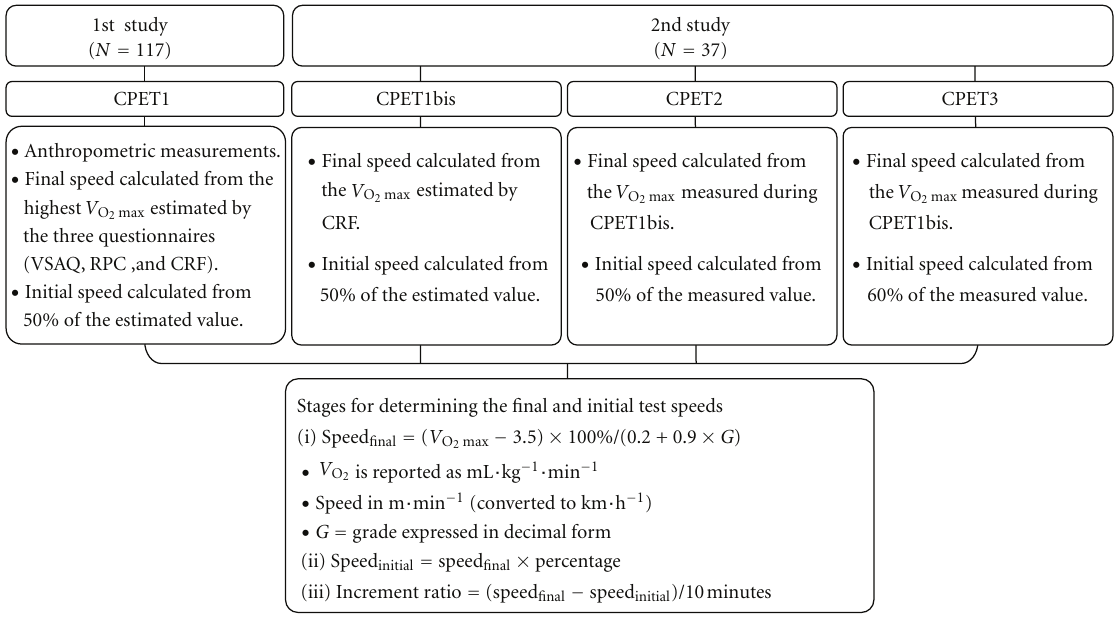
Figure 1: Flowchart of the 1st and 2nd studies including the procedures adopted to determine the workload increments, using nonexercise and ACSM running equation to calculate the treadmill speeds. V O models to estimate V O 2 max cardiopulmonary exercise test; VSAQ: Veterans Specific Activity Questionnaire; RPC: Rating of Perceived Capacity; CRF: Questionnaire of Cardiorespiratory